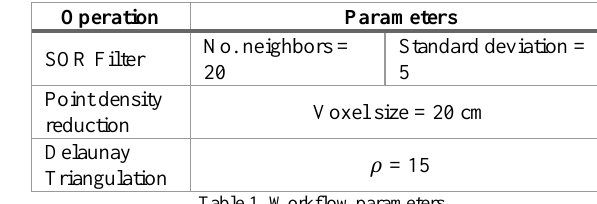
Figure 4. Workflow: Sun rays intersection with obstacles